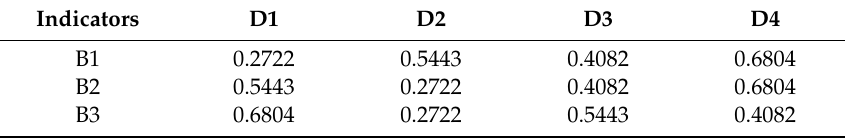
Table 7. Normalized decision-making